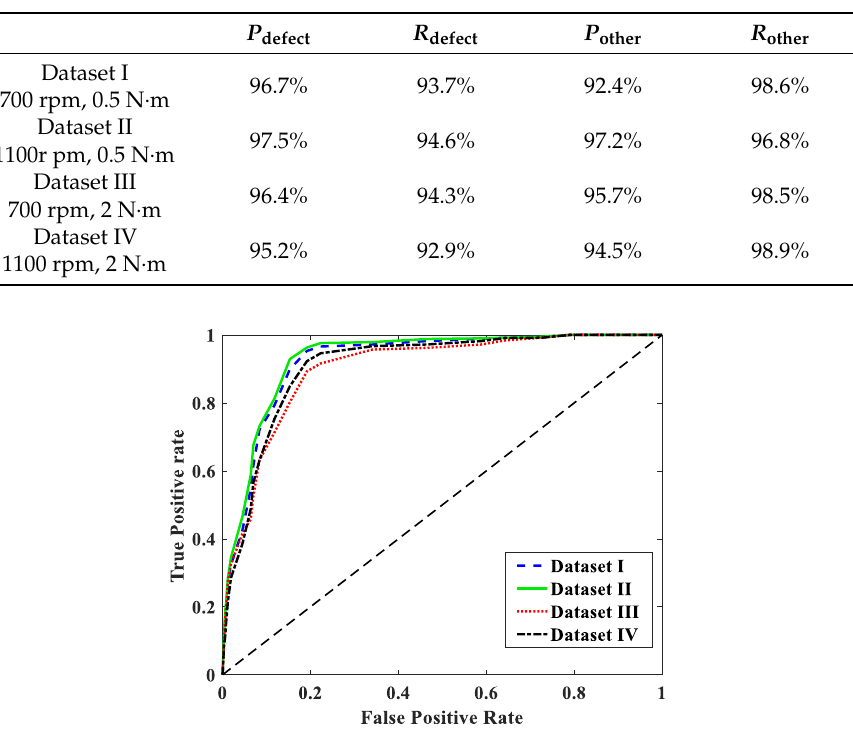
Table 4. The performance of the proposed method for di ff erent datasets.